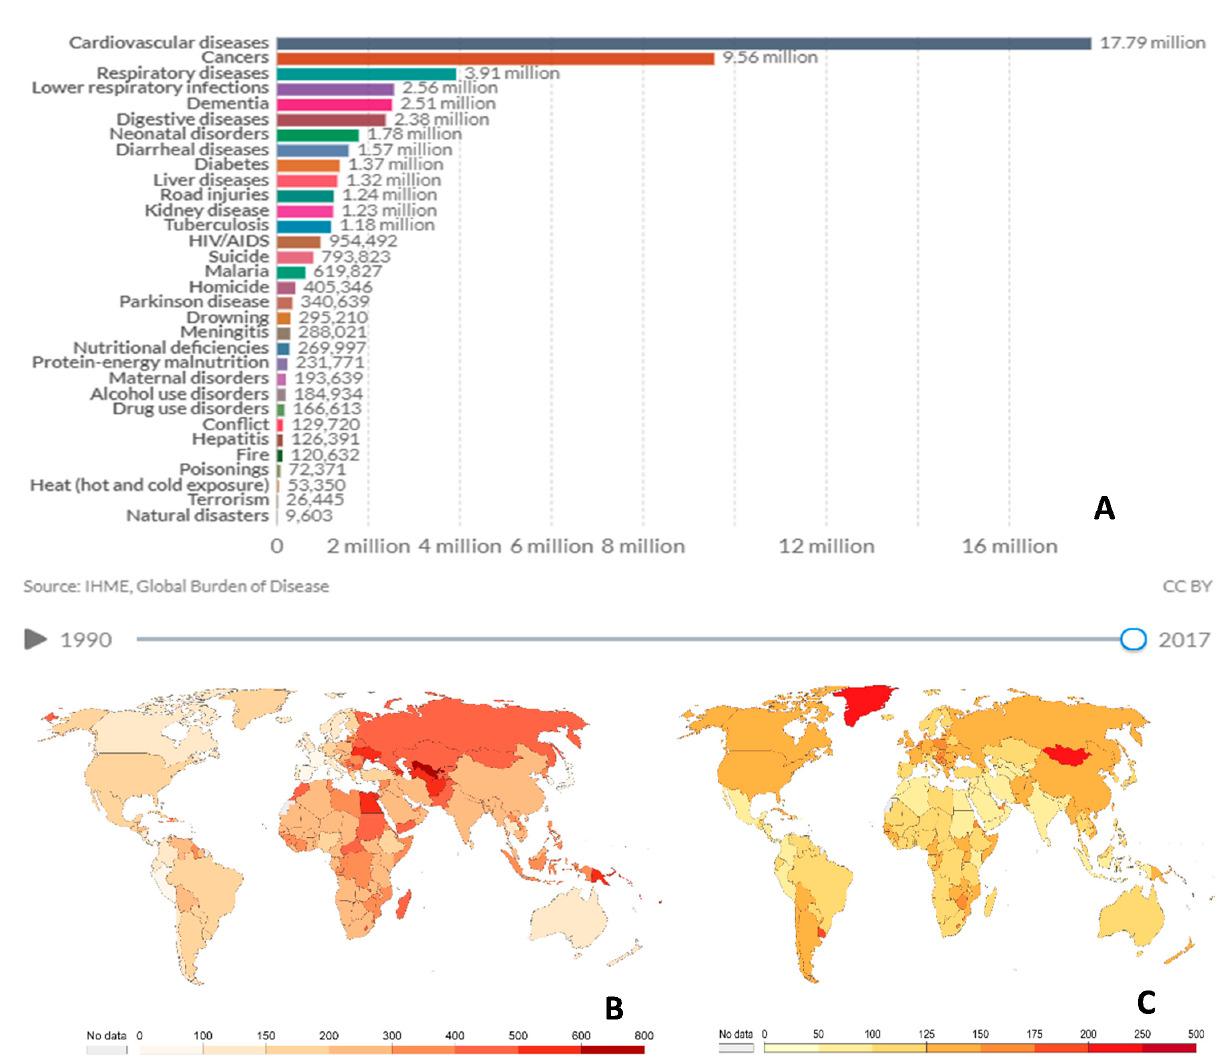
Figure 7. The number of deaths by cause from 1990 to 2017 ( A ); Death rate from cardiovascular disease ( B ). The death rate from cancer ( C ). Annual number of deaths per 100,000 people (data from 2017). To allow comparisons between countries and over time, this metric is age standardized. Data retrieved from Our World in Data [110] and World Heart Federation [111].